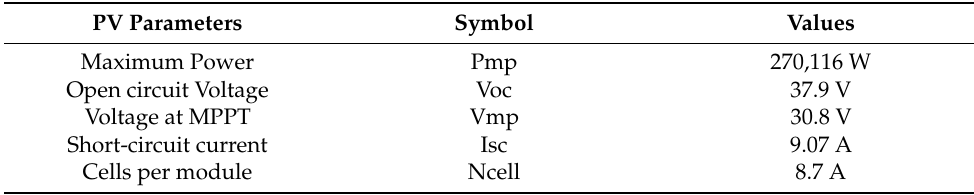
Table A1. Parameters of the PV module.